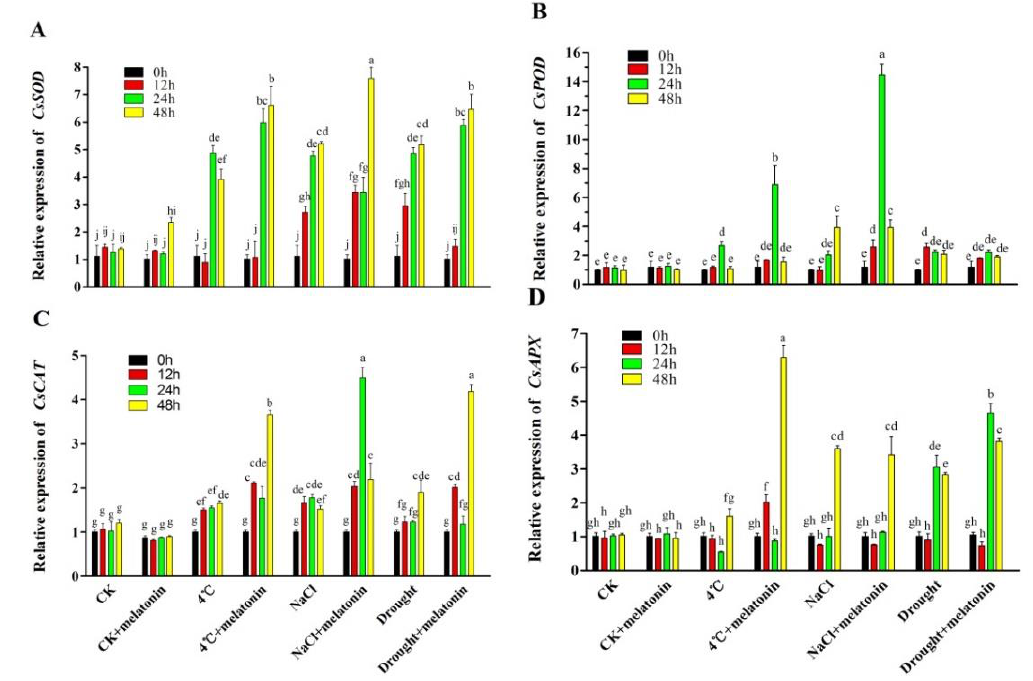
Figure 5. Effect of exogenous melatonin on gene expression in the biosynthesis of antioxidant enzymes in tea leaves on the designated times. ( A ) CsSOD , ( B ) CsPOD ( C ) CsCAT , ( D ) CsAPX . The tea plants were subjected to control (CK), cold stress (4 °C), high salt (300 mM NaCl) and drought stress (200 g·L − 1 PEG) with different treatments (CK and 100 μM melatonin). Data represent means ± SD of three replicate samples. Different letters indicate significant differences according to Duncan’s multiple range test ( P < 0.05).